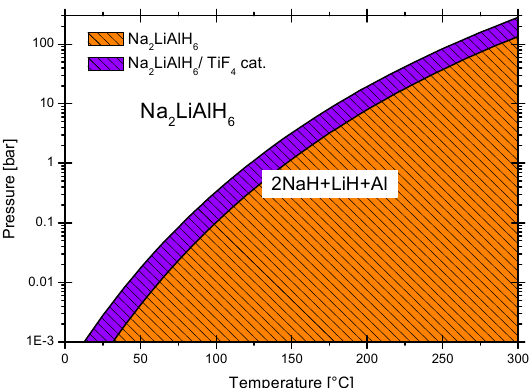
+ 17.0 for material catalyzed T (cid:3021)